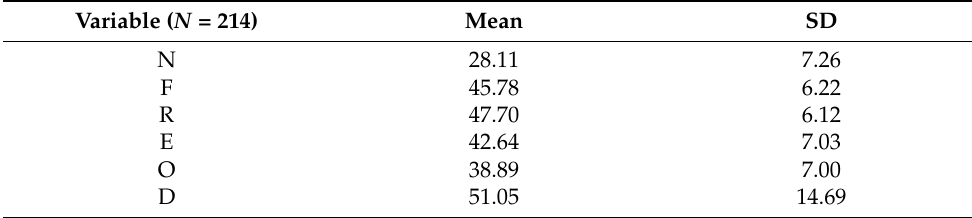
Table 1. Descriptive analysis.